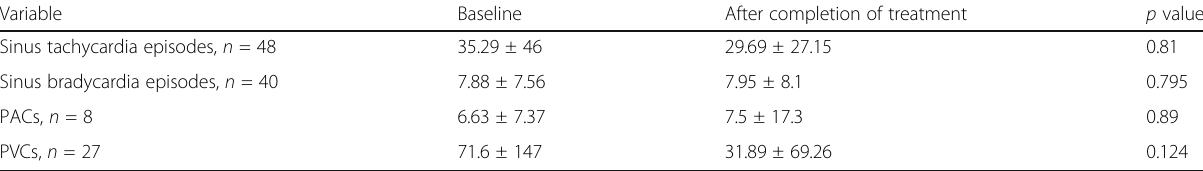
Table 3 Comparing patients with electrical events on Holter monitoring at baseline and after completion of treatment Variable Baseline After completion of treatment p